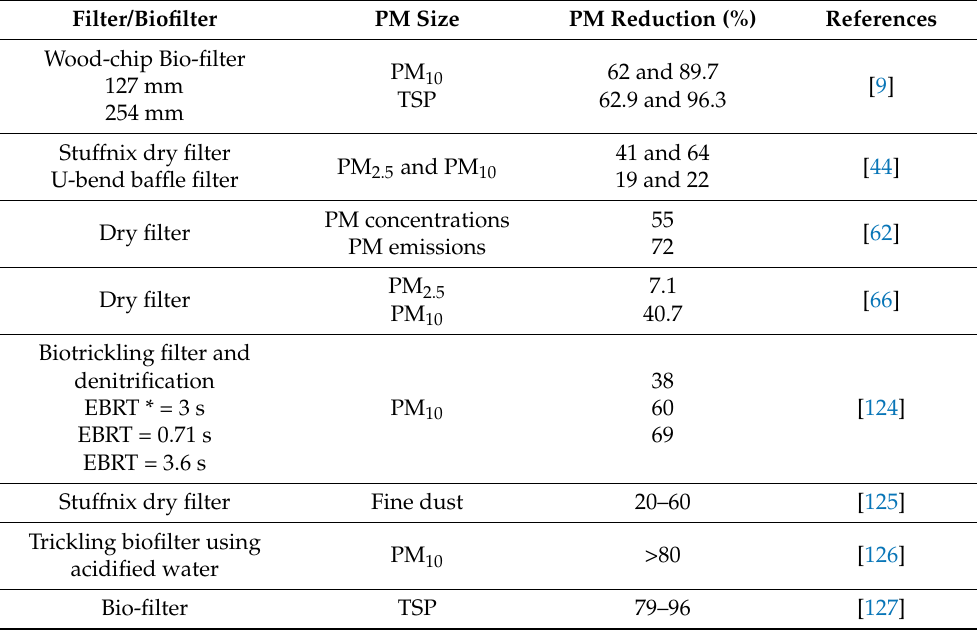
Table 10. Air filtration systems used to mitigate PM